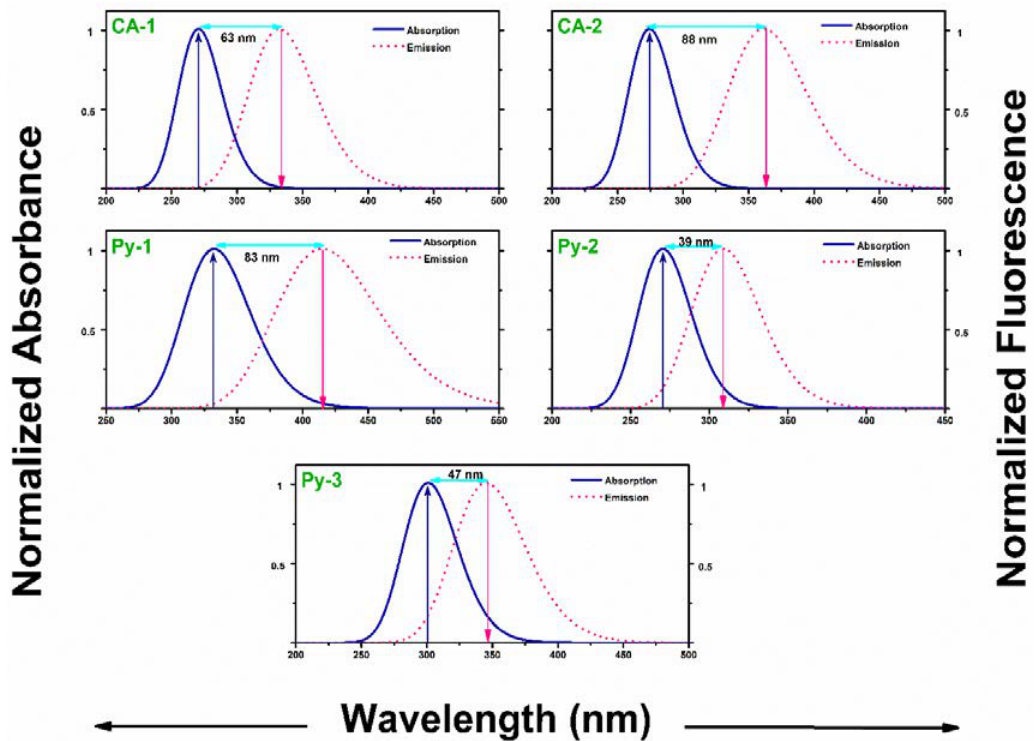
Figure 6. Absorption and emission spectra of the UV-dyes along with the calculated Stokes shift.